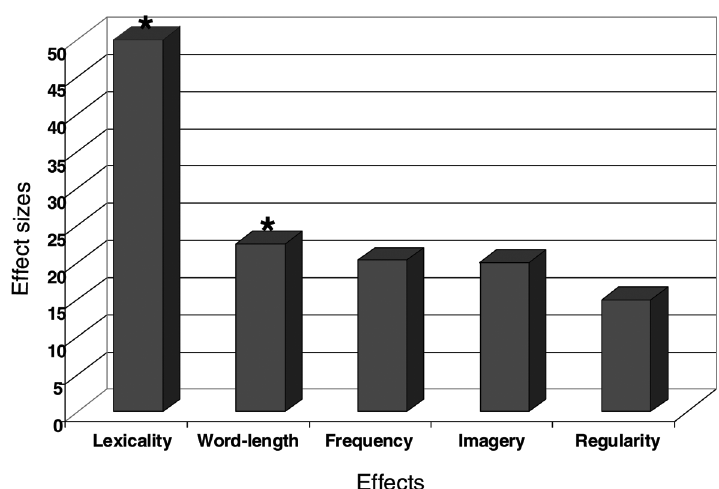
Figure 1. Analysis of linguistic variables on the pre- test reading evaluation. Lexicality effect =% of cor- rect responses to words minus % of correct re- sponses to non-words; Word-length effect =% of correct responses to short stimuli minus % of cor- rect responses to long stimuli; Frequency effect =% of correct responses to low frequency words minus % of correct responses to non-frequency words; Imagery effect =% of correct responses to abstract words minus % of correct responses to concrete words; Regularity effect =% of correct responses to irregular words minus % of correct responses to regular words * Significant effects: Lexicality (p <0.01) and word-length